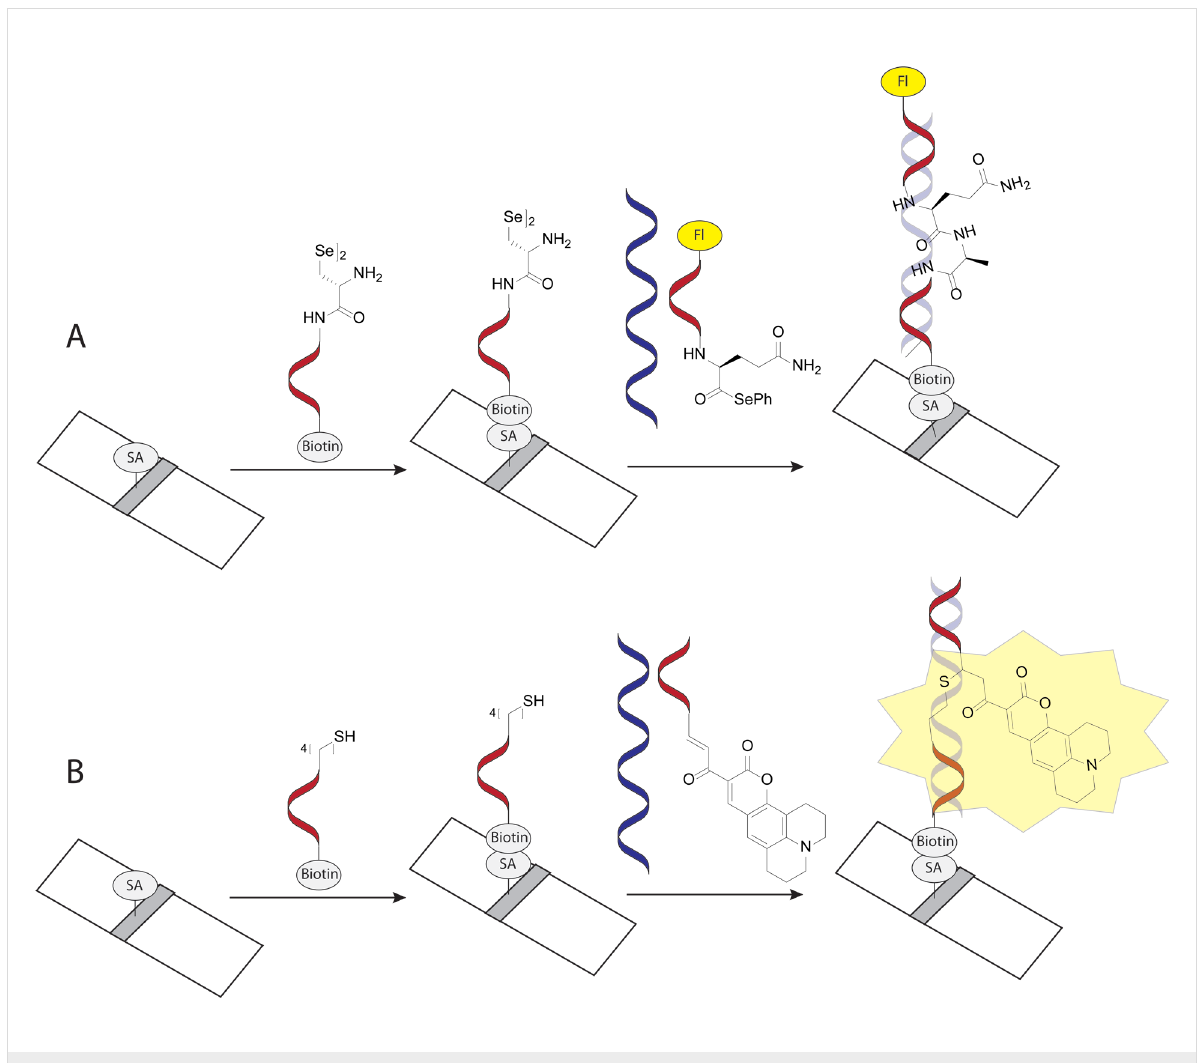
Figure 26: Lateral flow devices use a streptavidin labeled strip on nitrocellulose paper to anchor a capture PNA (red). The target oligonucleotide (blue) and the detection PNA probe (red) are then allowed to run the length of the strip. If the target is present, it will act as a hybridization scaffold bringing the two PNAs in proximity. This allows for either simple ligation (A) or fluorogenic ligation (B) which generates an optical signal allowing for detection of the